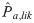
Cchisq and Chyper provide approximately equal estimates of the magnitude of the diversity constraints driving repeatability, while P^a,lik provides an estimate of the proportion of all genes that could potentially contribute to adaptation, which is not collinear with the C-scores.Plots show values calculated for simulated datasets generated by randomly drawing two arrays with gs genes, with ai loci adapted in one array and ai + 20 in the other, and then sorting a proportion of the rows in each array to artificially generate more repeatability than would occur by chance (with a different proportion sorted in each replicate). In Panel A&C, gs = 200; in panel B&D, ai = 10; P^a,lik calculated using Eq 4.